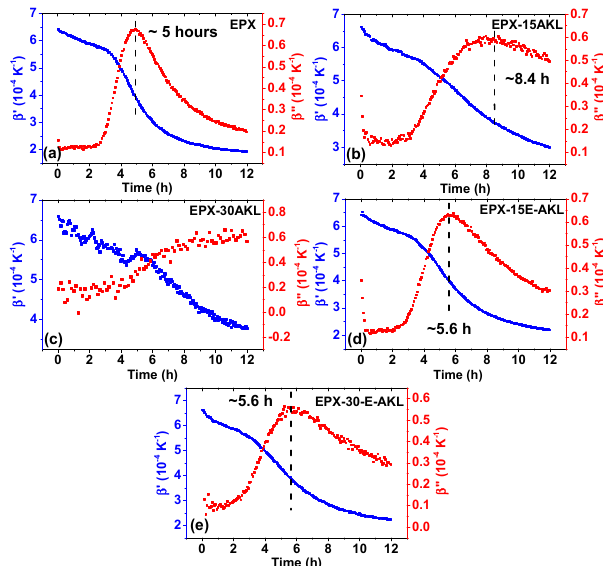
Figure 8. Temporal evolution of the dynamic thermal volume expansion coefficient of all samples (real part, b’, left axis and imaginary part, b’’, right axis). The chemically induced glass transition of each sample is indicated in the corresponding graph. ( a ) EPX, ( b ) EPX-15AKL, ( c ) EPX-30AKL, ( d ) EPX-15E-AKL, and ( e ) EPX-30-E-AKL.